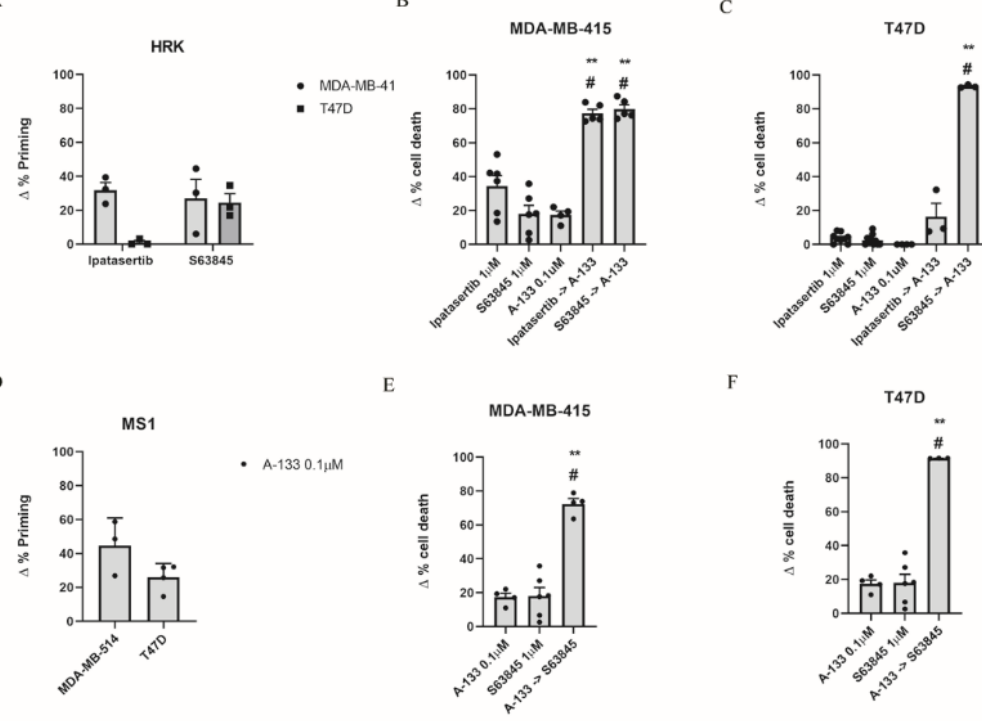
Figure 2. Dynamic BH3 profiling predicts BCL-xL and MCL-1 anti-apoptotic adaptation as a resistance mechanism after targeted agent treatment in ER+ breast cancer cell lines. ( A ) Results from the contribution of BCL-xL anti-apoptotic protein using the HRK peptide after ipatasertib 1 µ M and S63845 1 µ M treatment in MDA-MB-415 and T47D. Results expressed as ∆ % priming represents the increase in priming compared to control cells. ( B , C ) Cell death from Annexin V and propidium iodide staining and FACS analysis after 72 h incubation of MDA-MB-415 and T47D cells with the single agents alone or the sequential combination of ipatasertib or S63845 with A-133. ( D ) DBP from the contribution of MCL-1 anti-apoptotic protein using the MS1 peptide after A-133 0.1 µ M treatment. ( E , F ) Cell death analysis after 72 h incubation of MDA-MB-415 and T47D cells with the single agents alone or the sequential combination of A-133 and S63845 for 72 h. Values indicate mean values ± SEM. ** p < 0.01 compared to single agents and # indicates CI < 1. All experiments were performed at least three